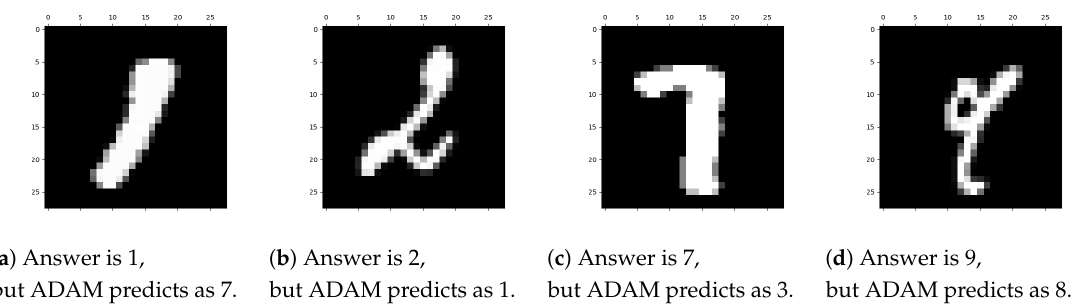
Figure 15. Examples that the proposed method predicted correctly, while the ADAM method does